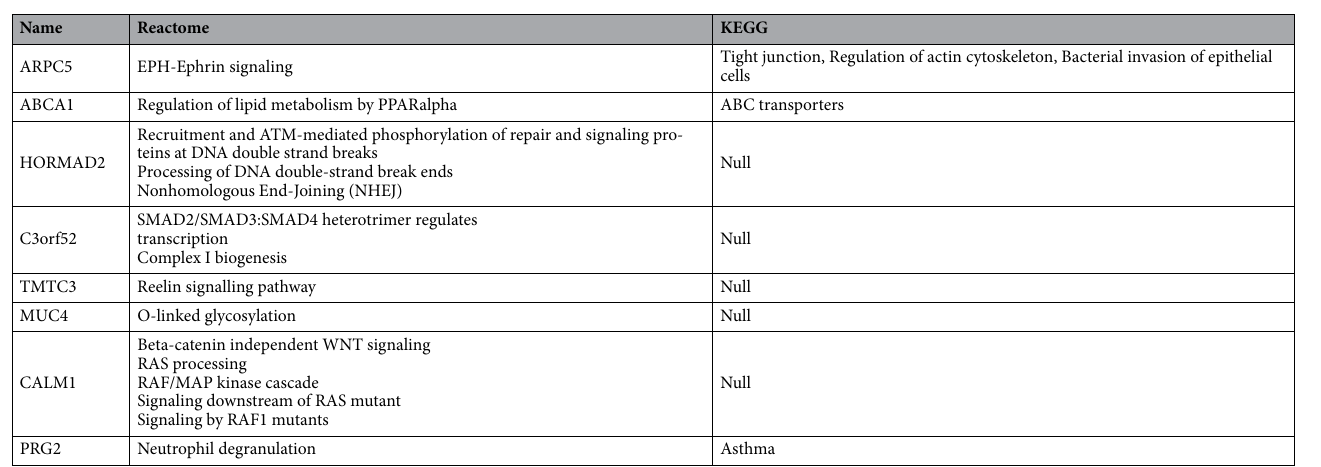
Table 3. Machine learning selected genes: Reactome and KEGG pathways involved. The pathways that could be related to squamous cell carcinoma of the lung are shown in Reactome column. Most of the genes do not have a pathway related to KEGG database, they are labeled as null. If there were more than three pathways available in either database just three pathways or less were selected when its biological function could be useful in cancer progression, growth, or maintenance. If just one pathway was available, it was written in the corresponding field. Null is used when no hits were found in the database. Only. genes that do not appear in either database were not